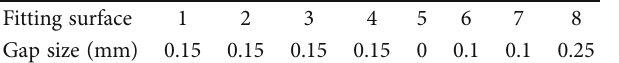
Figure 8: Two possible passageways that may lead to fl ame leak: (a) 1 → 2 → 3 → 4 and (b) 5 → 6 → 7 → 8. Table 4: The de fi ned initial gap sizes for the selected possible